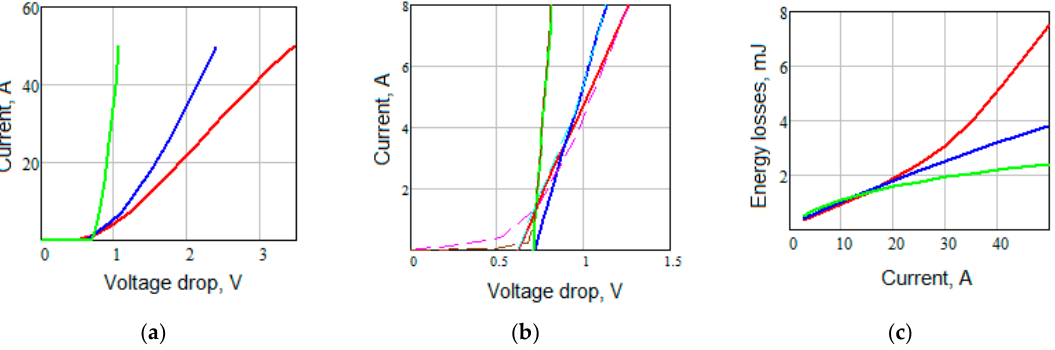
Figure 5. ( a ) Direct current-voltage characteristics of semiconductor elements [29]; red—IGBT; blue—reverse diode; green—uncontrolled rectifier diode; ( b ) solid line—linear approximation of (a); dotted line—source dependencies; ( c ) Dependence of switching losses on current [29] at rated voltage IGBT of the V rate module; red—IGBT turn on; blue—IGBT turn off; green—reverse diode turn off.